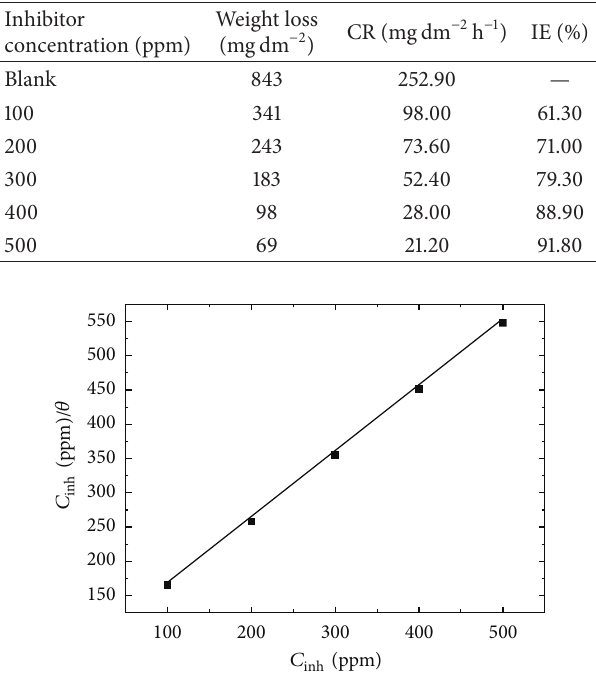
Figure 2: Langmuir adsorption isotherm plot of Marjoram extract adsorption on the surface of zinc in 1.0 M HCl.